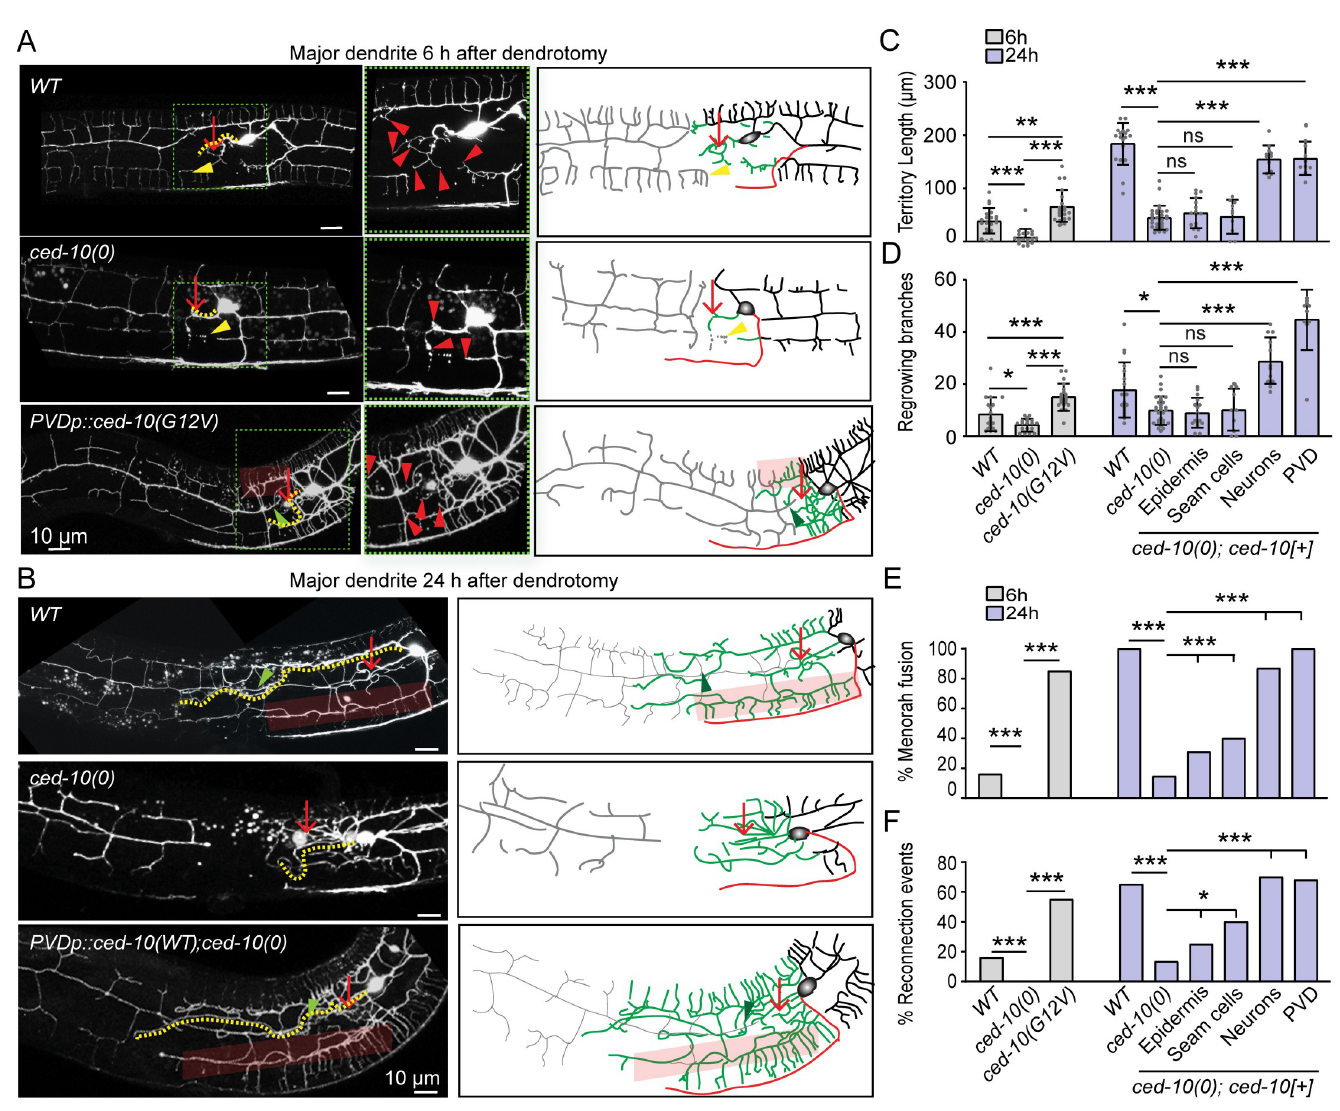
Fig 5. CED-10 is required in neuron for dendrite regeneration. (A) Confocal images of PVD in the wildtype, ced-10(0) and pser2prom3 :: CED-10(G12V) (Activated CED-10) at 6h post-dendrotomy along with their schematics indicating site of dendrotomy (red arrow), regrowing dendrites (green), distal part (grey), territory length (yellow dotted lines), reconnection phenomena (green arrowheads) and menorah-menorah fusion (faded red boxes). Red arrowheads represent the filopodia like structure at the tip of the cut dendrite, yellow arrowheads represent degenerating menorah. (B) Confocal images of PVD in the wildtype, ced-10(0) and pser2prom3 :: ced-10(WT); ced-10(0) at 24h post-dendrotomy along with their schematics. (C-F) The quantification of territory length (C), number of regrowing branches (D), the percentage of reconnection events (E), and percentage of menorah-menorah fusion events (F) in the wild type, ced-10(0) and pser2prom3 :: ced-10(G12V) at 6h post-dendrotomy. For the 24h post-dendrotomy time point, the data from the wild type, ced-10(0) , pdpy-7 :: ced-10(WT) (epidermis) ;ced-10(0) , pgrd-10 :: ced-10(WT) (seam cells) ;ced-10(0) , prgef-1 :: ced-10(WT) (All neurons); ced-10(0) and pser2prom3 :: ced-10(WT) (PVD); ced-10(0) genetic backgrounds were presented. For (C-F), N = 3–5 independent replicates, n (number of regrowth events) = 10–26. Statistics, For C-D, One-way ANOVA Tukey’s multiple comparison test considering p < 0.05 � , 0.01 �� , 0.001 ��� . For E-F, Fisher’s exact test taking p < 0.05 � , 0.01 �� , 0.001 ��� . Error bars represent SD. ns, not